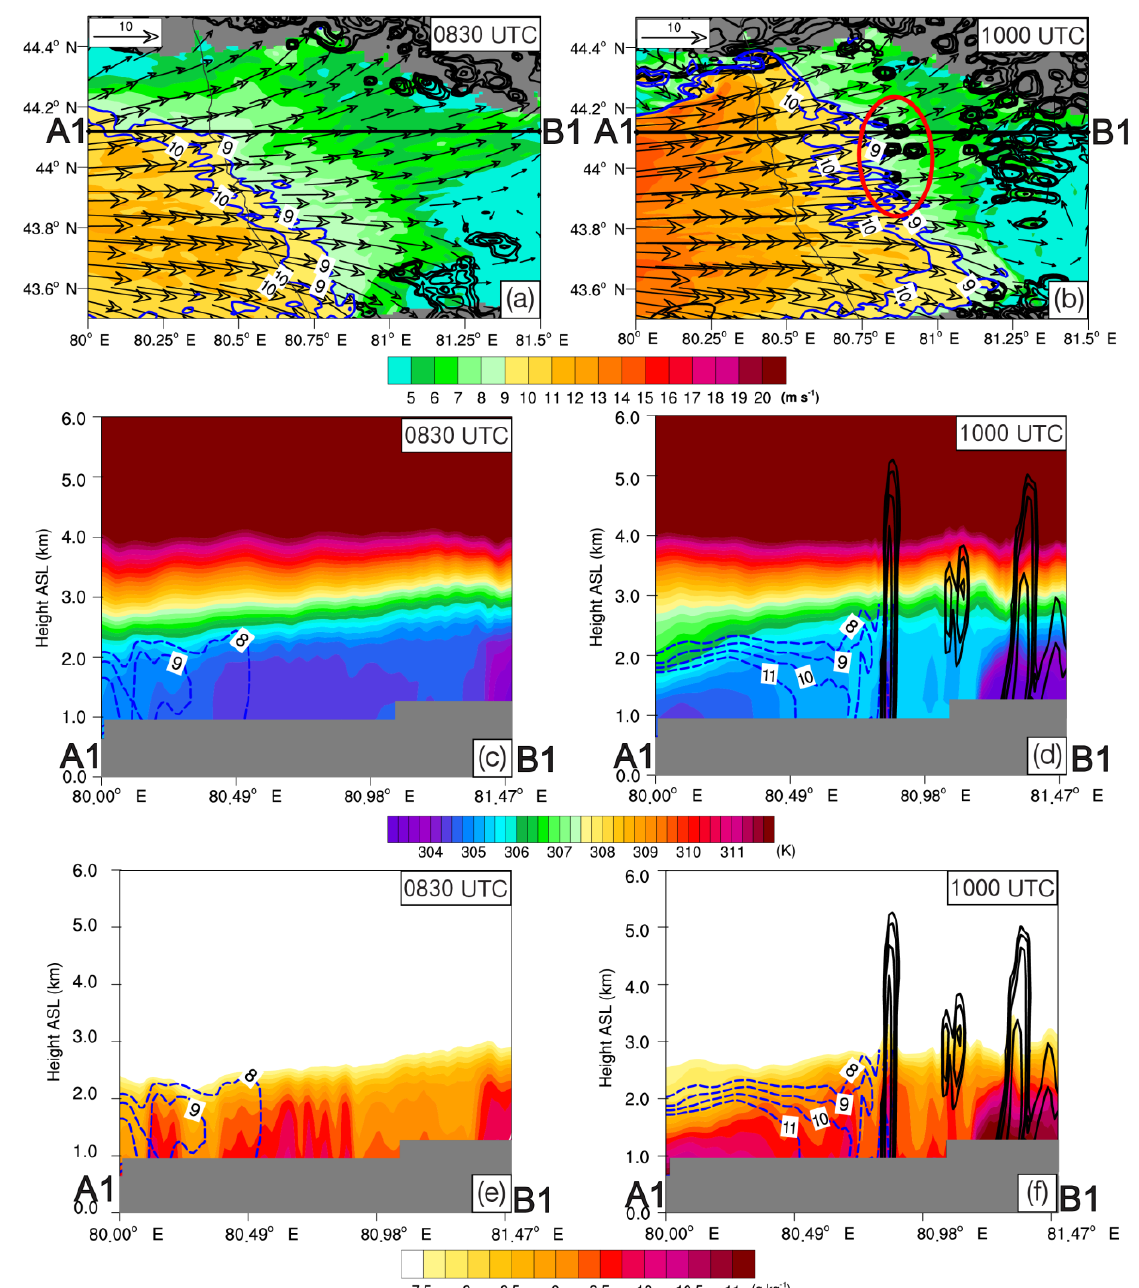
Figure 9. ( a , b ) Simulated horizontal velocity (shading and blue contours, units: m s − 1 ) and composite reflectivity (thin black contours, unit: dBZ, with 5 dBZ intervals) at 1500 m (ASL) on 17 June 2016. The dark grey shadings show the area that surface altitude >1500 m (ASL). ( c , d ) Vertical cross section of potential temperature (shading, units: K), horizontal velocity (dashed blue lines, units: m s − 1 ) and composite reflectivity (thin black contours, unit: dBZ, with 5 dBZ intervals) along the line segment A1B1 which was shown in ( a , b ). ( e , f ) are the same as ( c , d ) but for the water vapor mixing ratio (shading, units: g kg − 1 ). The specific time is shown in the upper right corner of each panel. The dark grey shadings show the area below ground surface.